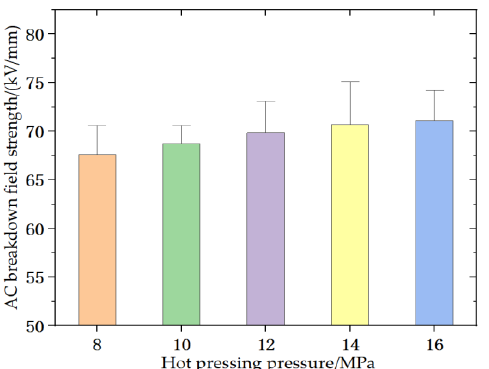
Figure 8. AC breakdown strength of oil-impregnated paper with different hot pressing pressures.